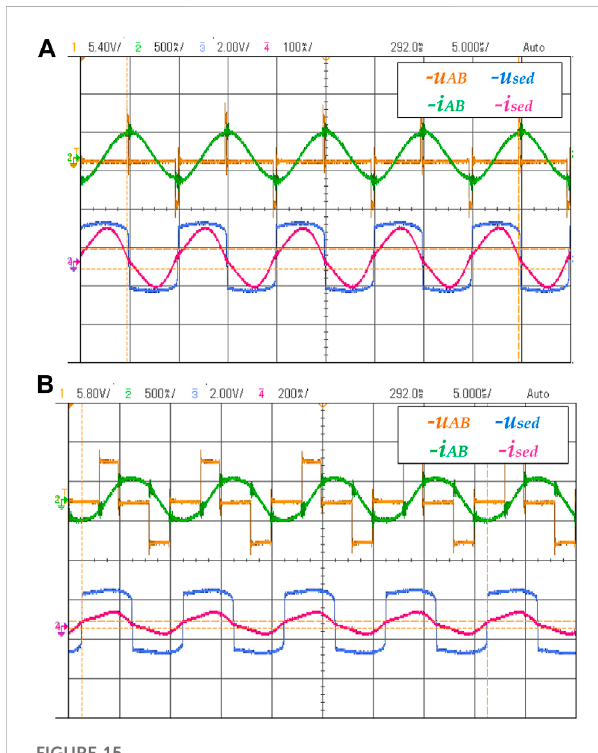
FIGURE 15 (A,B) are the waveform of the current and voltage on the primary and secondary sides of the resonator without and with the auxiliary inductor, respectively.